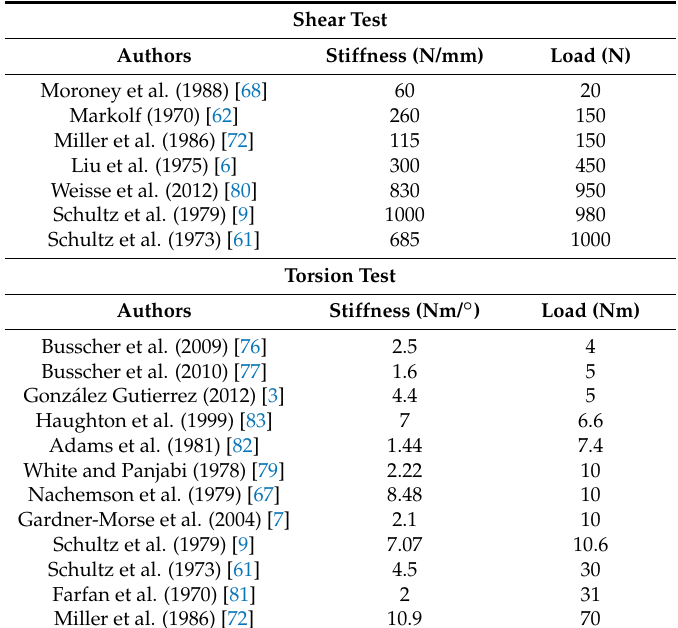
Table 5. Stiffness and loads for the shear and torsion tests by various